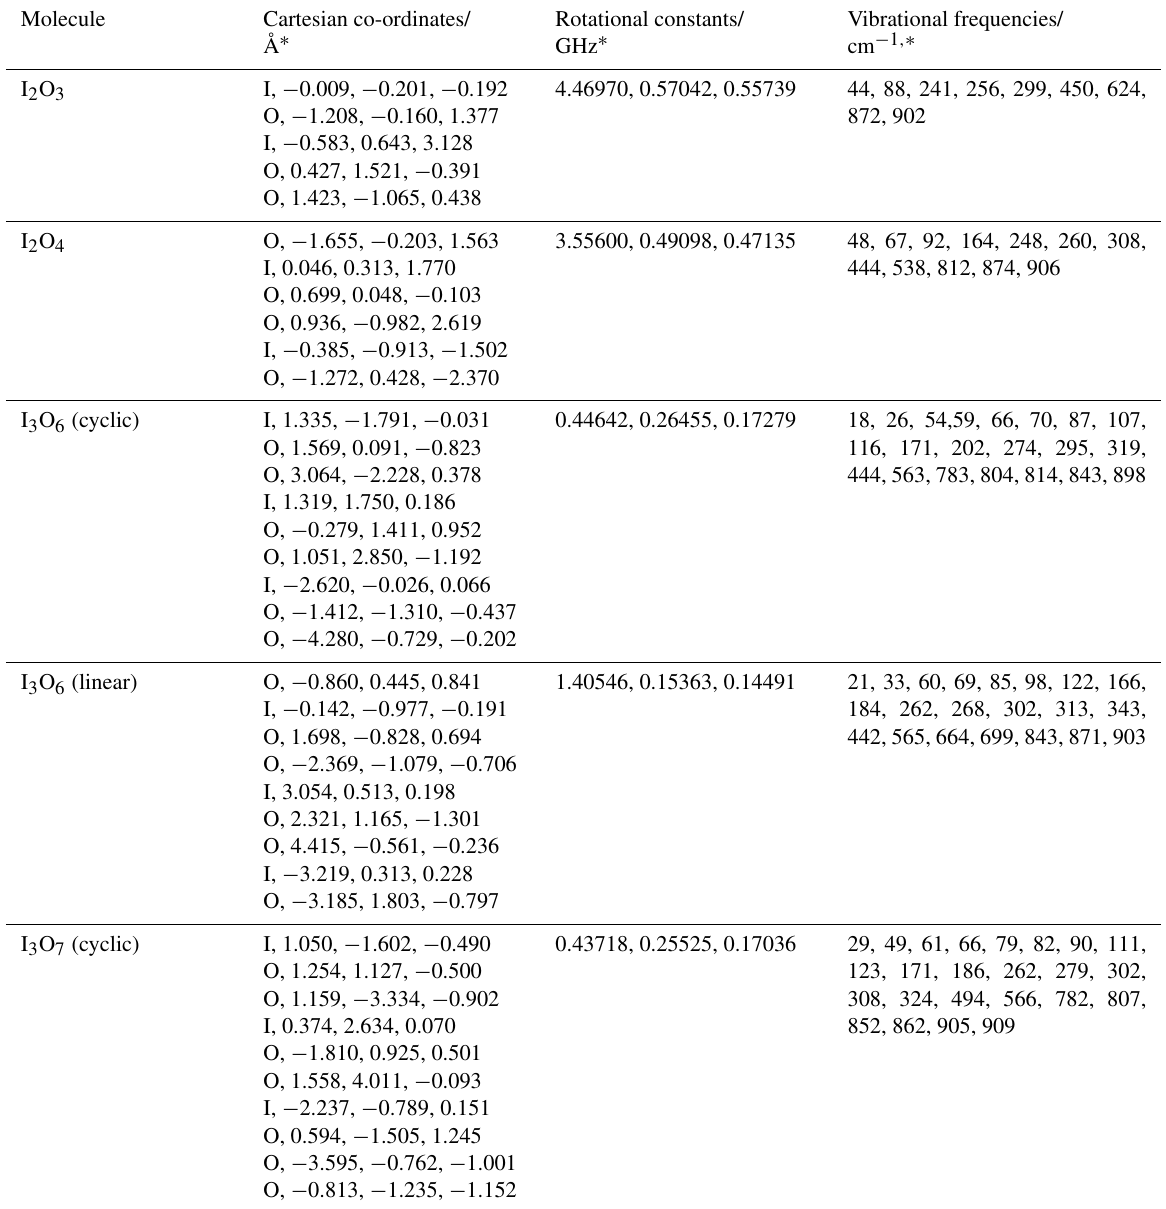
Table A1. Molecular properties of I 2 O 3 , I 2 O 4 , I 3 O 6 (cyclic), I 3 O 6 (linear), I 3 O 7 (cyclic), I 3 O 7 (linear), IO 3 , and the transition state for dissociation of IO 3 to IO + O 2 (illustrated in Fig. A1), and the stationary points on the IO 3 + HO 2 surface (Fig. 12). Molecule Cartesian co-ordinates/ Rotational constants/ Vibrational frequencies/ Å ∗ GHz ∗ cm − 1 ,